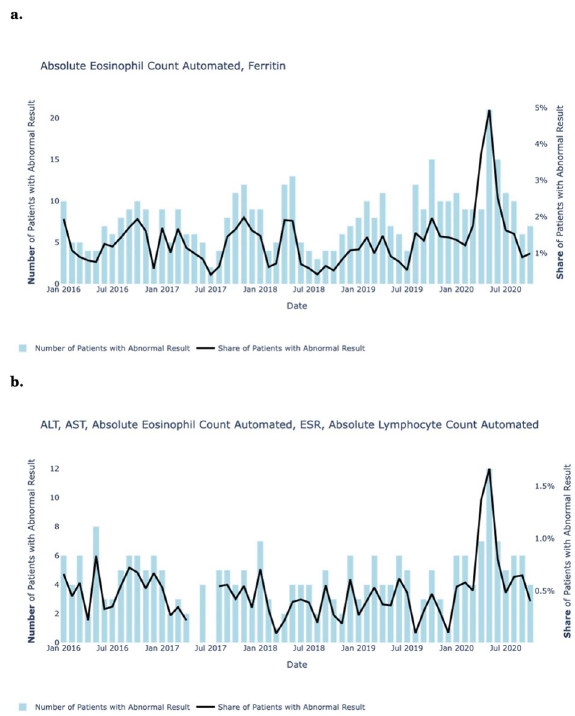
Fig. 3 Population approach, laboratory test combinations. The total number of monthly abnormal test results (blue bars) and test abnormality rates (black line) recorded from January 2016 through August 2020, for selected combinations of clinical laboratory tests: a eosinophil and ferritin; b ALT, AST, eosinophil, ESR, and